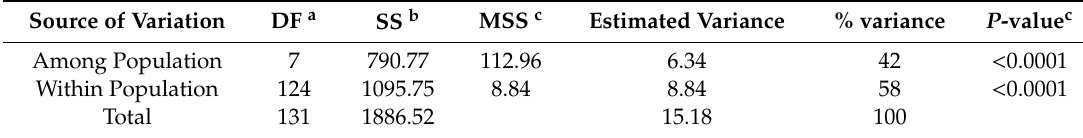
Table 5. Analysis of molecular variance (AMOVA) among the eight sub-populations identified by ‘STRUCTURE’ software. Source of Variation Estimated Variance Among Population Within Population Total